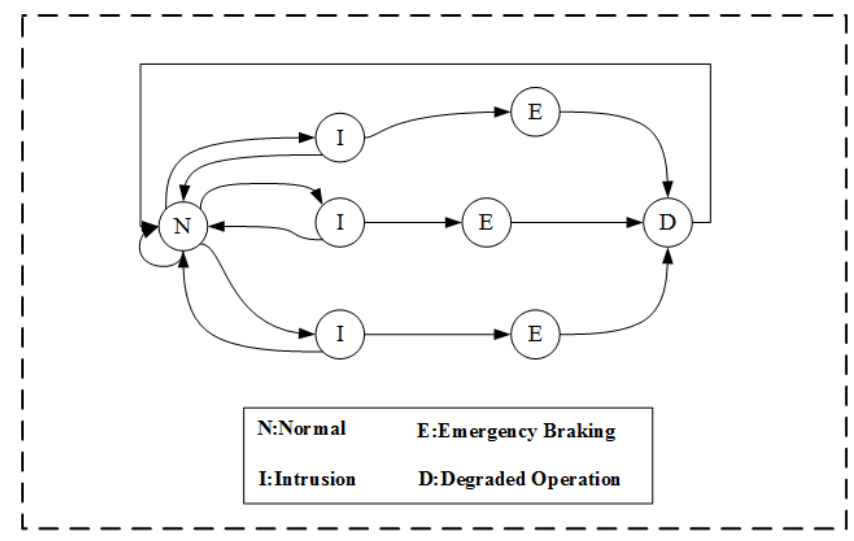
Figure 6. Continuous time Markov chain (CTMC) model. Table 8. Steady-state probability of communication-based train controls (CBTC)